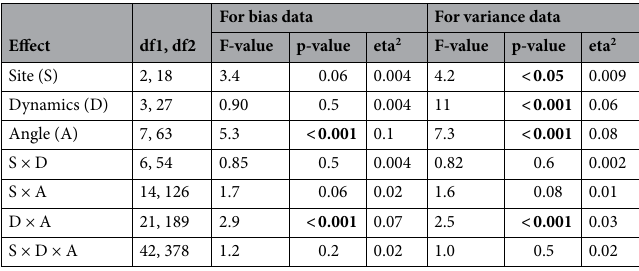
Table 5. Results from the ANOVAs of Experiment